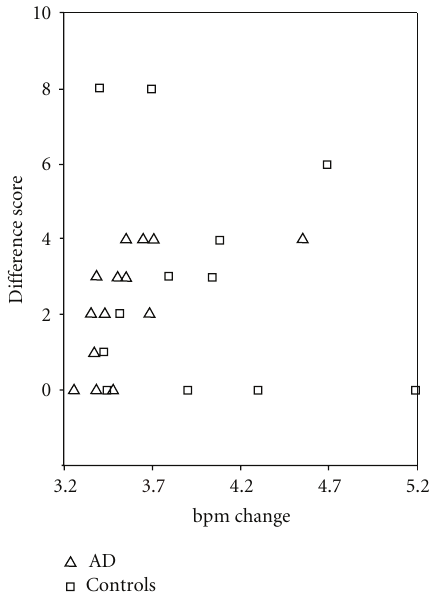
Figure 2: Interaction plot showing di ff erence scores of arousal ratings in dependence of log function of mean heart rate response to faces associated with pleasant and unpleasant content for patients and